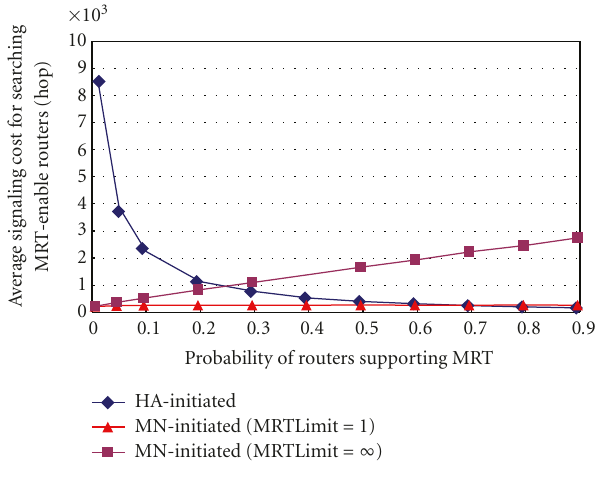
Figure 5: MRT-enabled routers discovery cost.